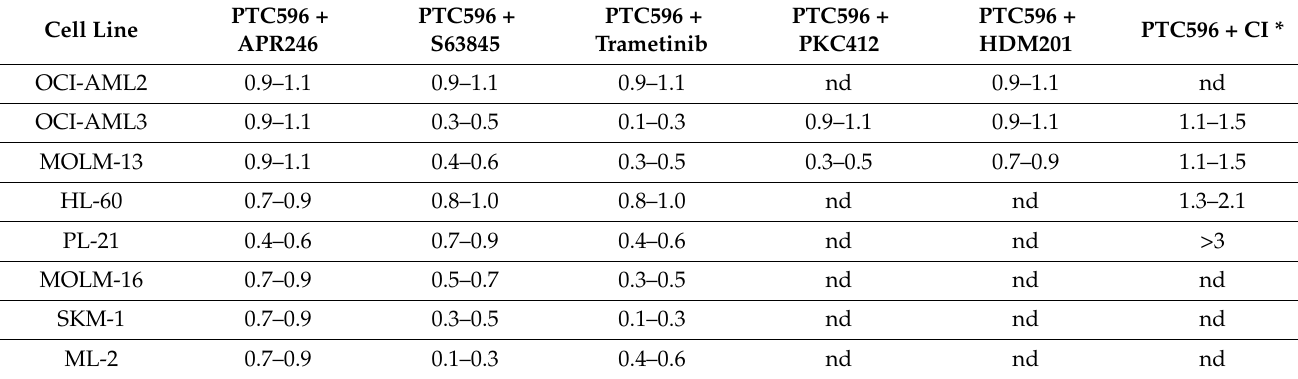
Figure 3. Susceptibility of AML cell lines to various treatment combinations. Cell viability was determined in AML cells after 20 h treatment with single compounds and in combination with PTC596 and APR246 ( A ), PTC596 and S63845 ( B ), and PTC596 and trametinib ( C ). Table 2. Combination index values AML cell lines (Chou and Talalay).